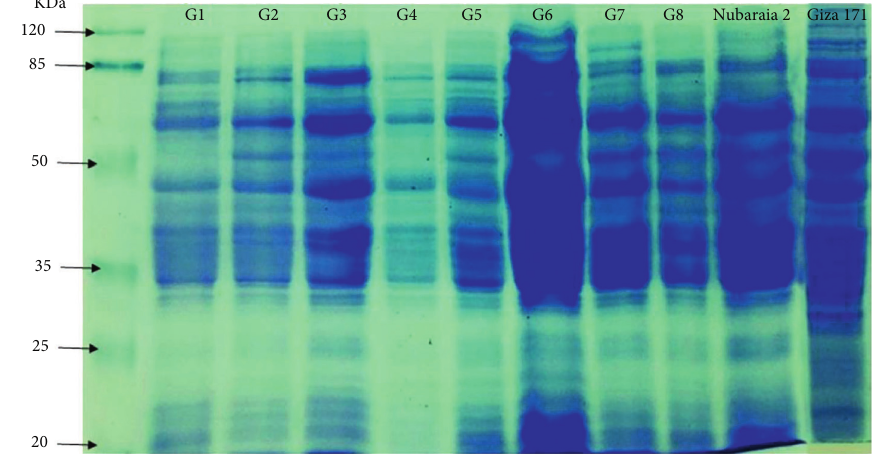
Figure 4: SDS-PAGE profile of the ten wheat